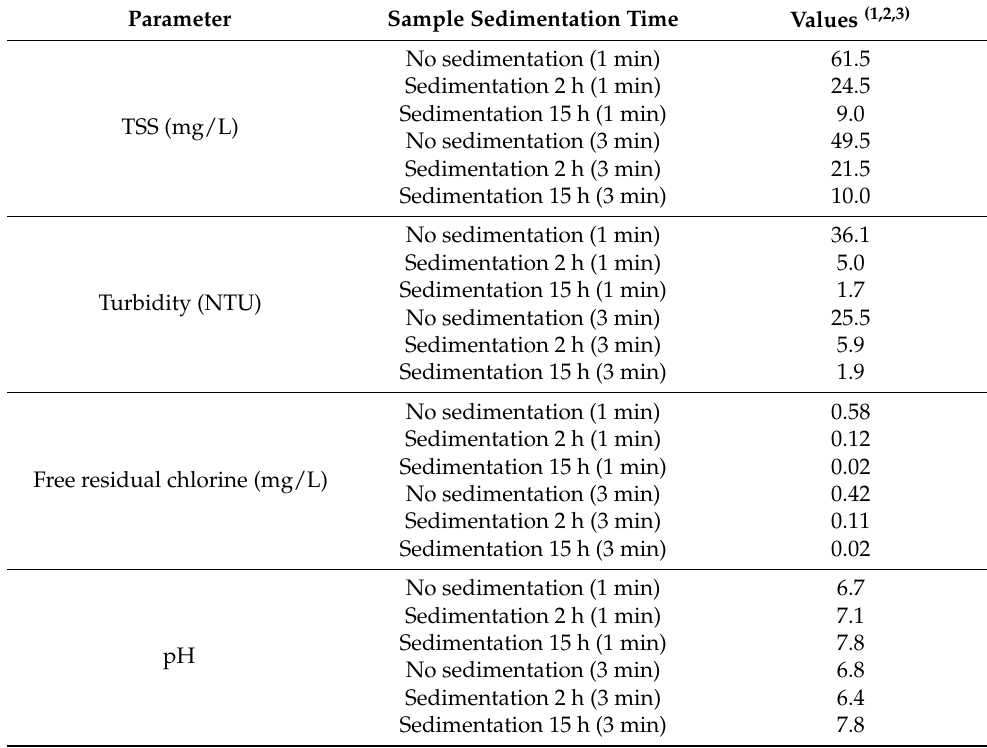
Table 5. TSS, turbidity, free chlorine, and pH values observed in 1st and 3rd minute. Filter- backwashed water samples were submitted to different sedimentation